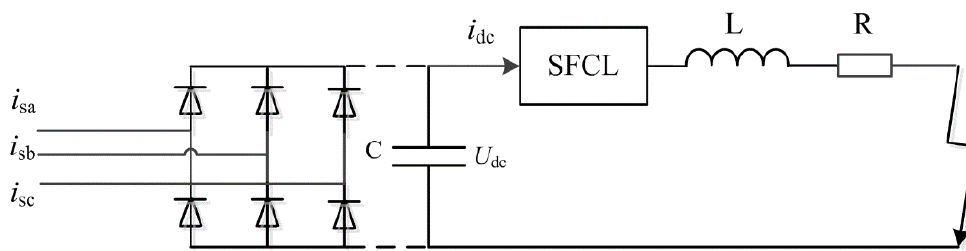
Figure 6. The equivalent circuit of the VSC in the initial phase of the fault.